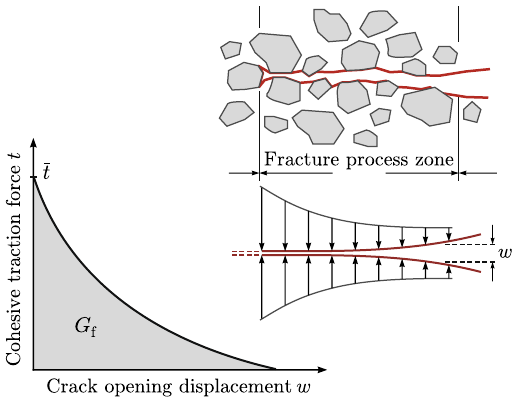
Fig. 2 Relationship between cohesive-traction force and crack-opening displacement in fracture process zone of quasi-brittle materials The substitution of Eqs. (13) and (14) into (12) yields the following relationship